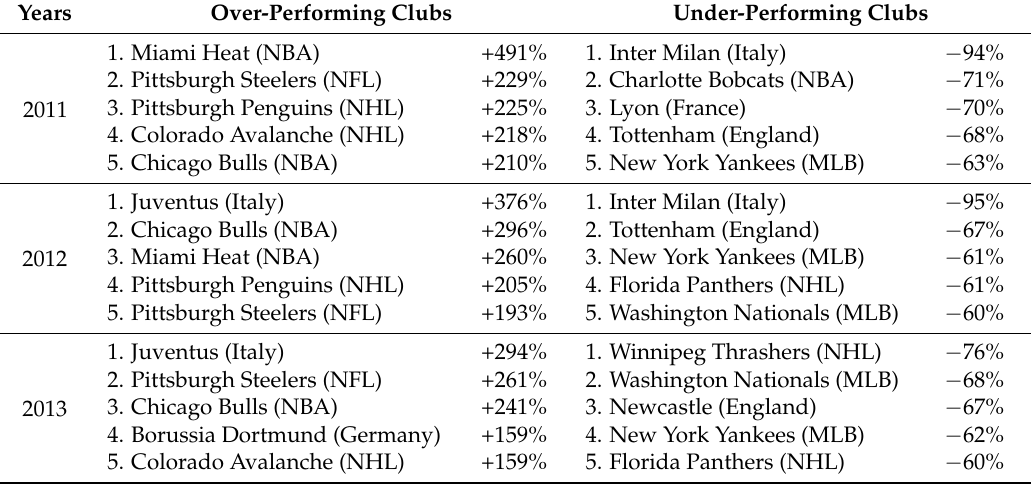
Table 5. Over- and under-performing clubs on Facebook in relative values.